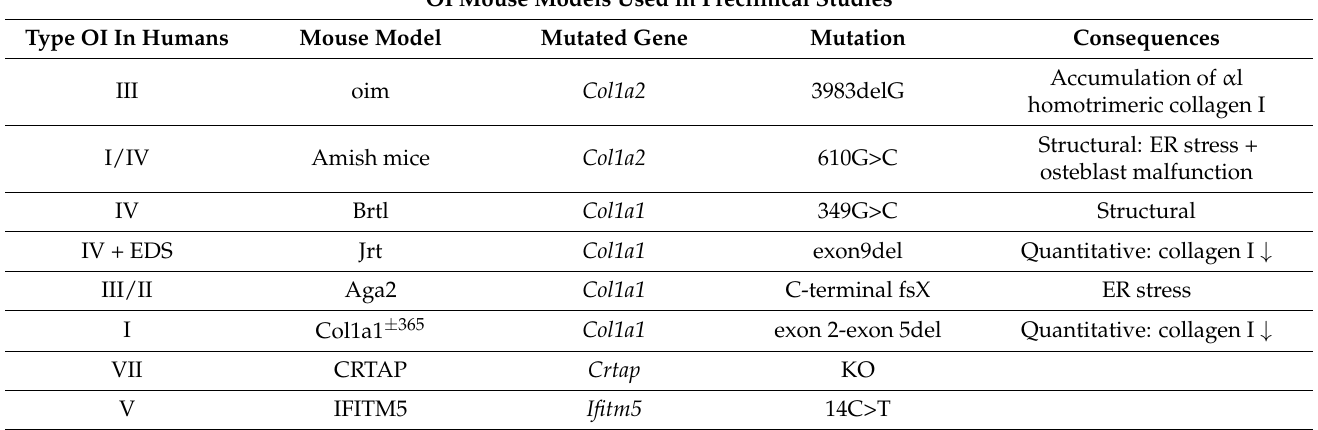
Table 1. OI murine models already used in preclinical studies. Models mimicking different types of OI. In all cases, similar mutations are reported in humans, except in the case of knockout mutations. OI Mouse Models Used in Preclinical